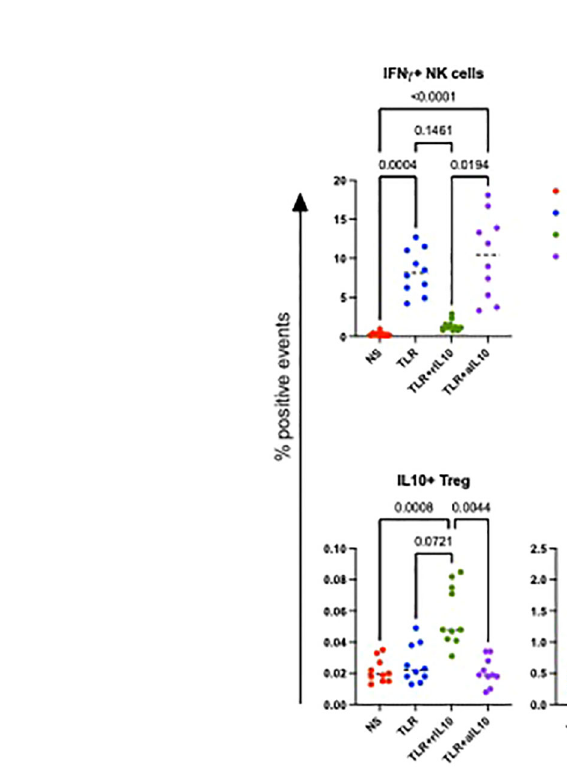
FIGURE 6 Effect of rhIL10 and anti-hIL10 treatment of TLR-stimulated PBMC cultures. Data were derived using PBMC from 5 HUU at birth and 5 HUU at 6 months of life. Scatter plots show individual sample results, medians, and select p values calculated by Friedman ’ s test for nonparametric repeated measures using Prism software